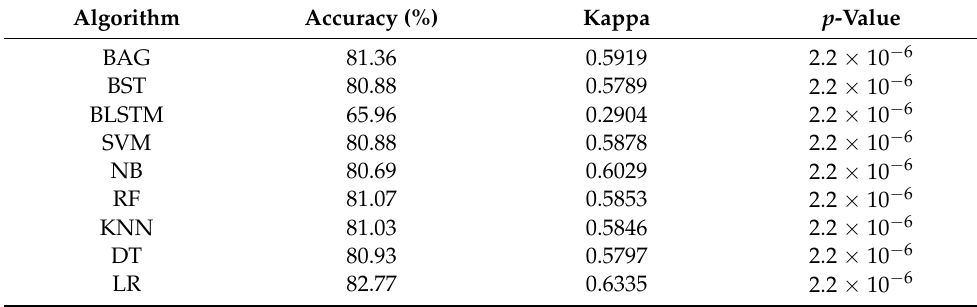
Table 3. Performance Metrics of BAG, BST, BLSTM, SVM, NB, RF, KNN, DT, and